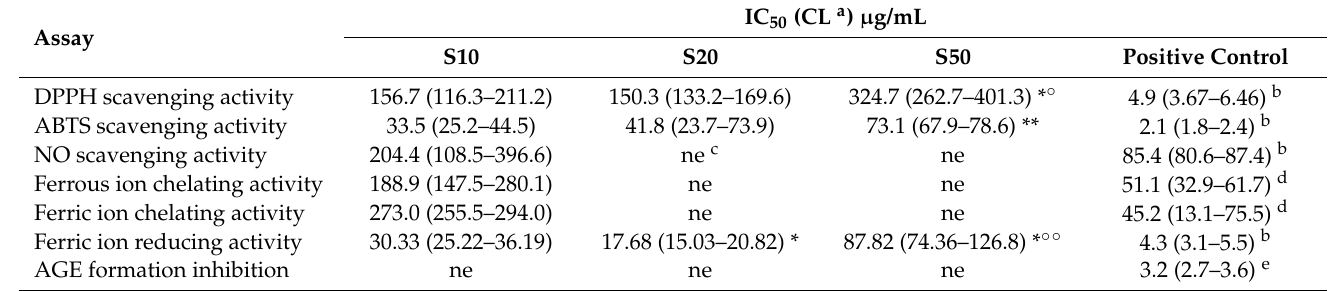
Figure 1. Scavenger activity towards ( A ) DPPH, ( B ) ABTS, and ( C ) NO radicals of S10, S20, and S50 fractions from Sideritis sipylea Boiss. Data represent the average and standard error of at least three independent experiments ( n = 3). Table 3. IC 50 values ( µ g/mL) of S10, S20, and S50 fractions from Sideritis sipylea Boiss and the positive controls for radical scavenging activity, iron chelating, and reducing effect, and inhibition of advanced glycation end products (AGE).